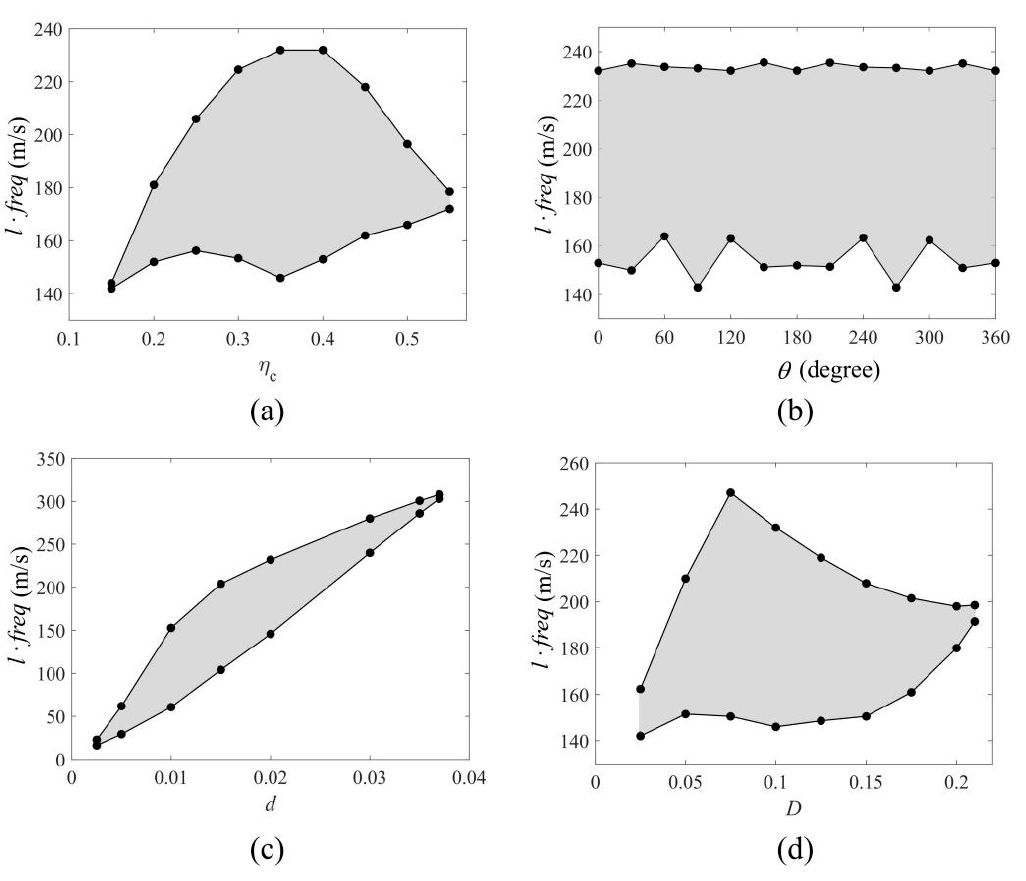
Figure 12. The relationship of different parameters ( a ) η c ( b ) θ ( c ) d ( d ) D on band gaps of the primitive cell by moving P 1 and P 2 in opposite directions horizontally.